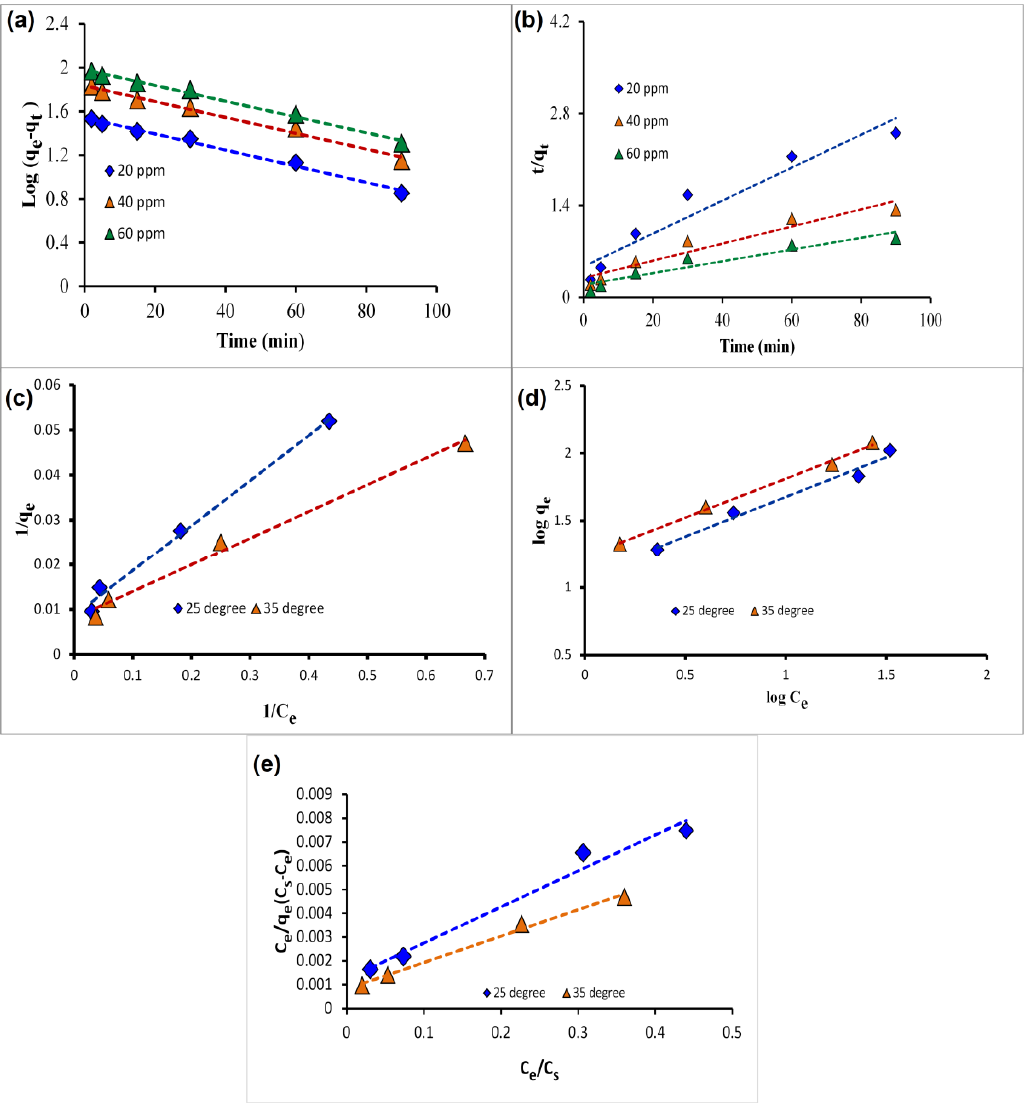
Figure 5. Adsorption kinetic models ( a ) Pseudo-first-order, ( b ) Pseudo-second-order, and Adsorp- tion isotherm models ( c ) Langmuir isotherm, ( d ) Freundlich isotherm and ( e ) BET isotherm .